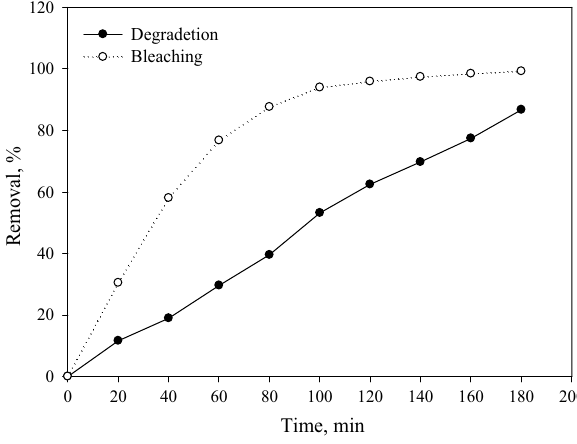
Fig. 15 Effect of photocatalytic efficiency in real environment (tap water) on the rate bleaching and dye degradation of MO. pH 6, 200 mg L −1 photocatalyst, 100 mL of tap water containing methyl orange 10 mg L −1